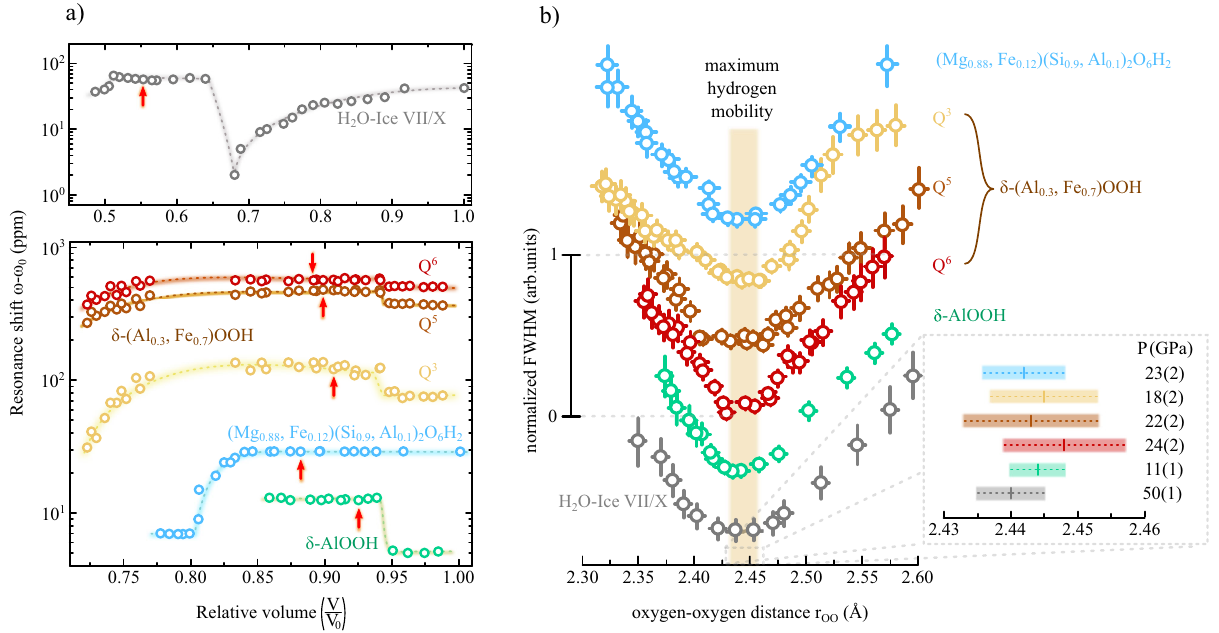
Fig. 4 Resonance shift and FWHM line widths. a Top panel: Resonance shift found in 1 H-NMR solid echos of H 2 O ice VII/X (gray). The signal shift of the resonances follows the dependence previously reported at high magnetic fi elds 13 : after an initial decrease up to 20 GPa ( V / V 0 ≈ 0.68), the signals are shifted down fi eld corresponding to the transition from a high to low barrier hydroge- bond regime. The second jump at 73 GPa ( V / V 0 ≈ 0.52) signi fi es the onset of the ice-VII → X crossover. Lower panel: Resonance shift of δ -AlOOH (green), δ -(Al,Fe)OOH (red, brown and yellow corresponding to Q i (i = 1...3) respectively) and phase-D (blue) as a function of the relative volume. Both δ -AlOOH and δ − (Al 0.3 ,Fe 0.7 )OOH undergo a sub to supergroup phase transition from P 2 1 nm to Pnnm which was observed at V / V 0 ≈ 0.94 by a sudden increase of the shift by about 5 – 10 ppm. Between V / V 0 ≈ 0.83 − 0.78, both iron bearing δ -(Al 0.3 ,Fe 0.7 )OOH as well as phase-D undergo an electron spin crossover, resulting in a partial reduction of the paramagnetic shift interaction as well as a volume collapse observed in Q 3 , Q 5 and Q 6 . The red arrows mark the points of maximum hydrogen mobility. Error bars, center of gravity of resonance signals, are within symbol size. b Normalized FWHM line widths (same color code as in a ), i.e. along F1 for the 2D-LG NMR spectra and in the direct frequency domain for the one dimensional spectra, as a function of r OO . All investigated systems go through a maximum of proton mobility (shaded area in the graph), i.e. motional narrowing of resonance lines and a consequent minimum of FWHM line widths at critical oxygen-oxygen ¼ 2 : 44 and 2.45, with an average value of (cid:1) r crit ¼ 2 : 443 ð 1 Þ Å . Error bars stem from fi tting of FWHM linewidths using Voigtian distances between r crit OO OO